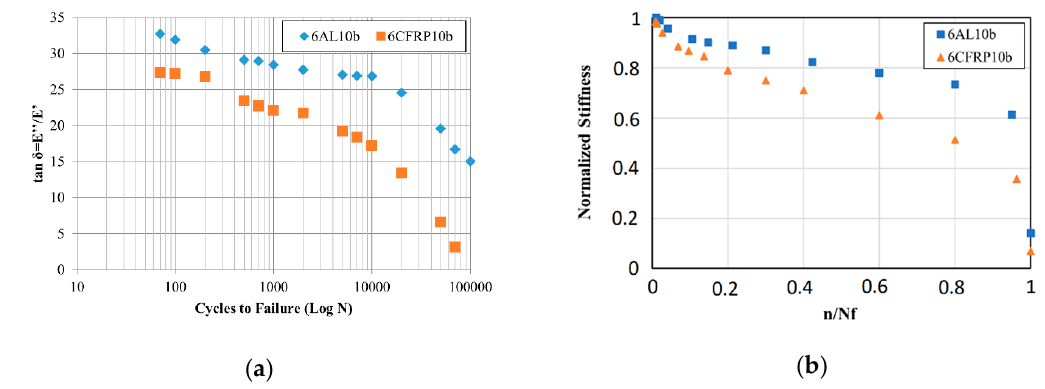
Figure 12. ( a ) Tan ( δ ) vs. Log (N) graph for the 6AL10b and 6CFRP10b specimens, ( b ) Stiffness reduction vs normalized cycle graph for 6AL10b and 6CFRP10b specimens.